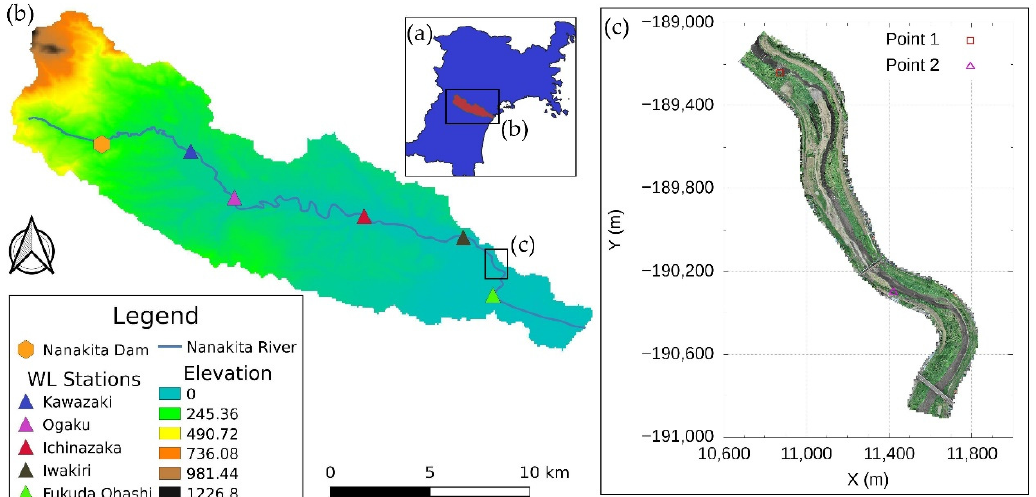
Figure 1. Study area: ( a ) Location of the Nanakita River basin in Miyagi prefecture; ( b ) basin map with the topography used as calculation area for the rainfall-runoff inundation model; ( c ) the 2 km stretch of the Nanakita River obtained from the UAV observation of September 2019 used as calculation area for the 2D hydraulic model.